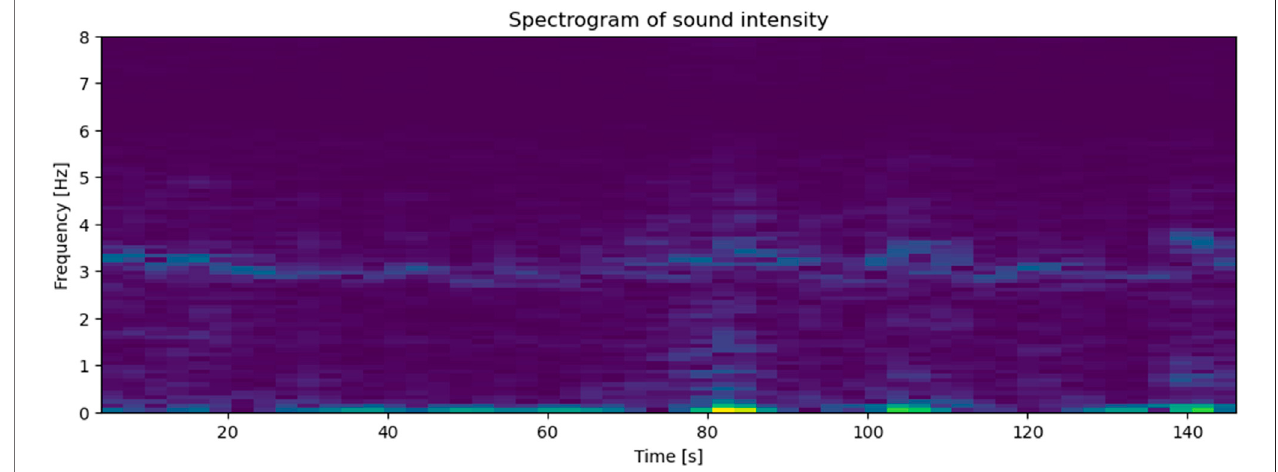
FIGURE 5 | Spectrogram of the sound